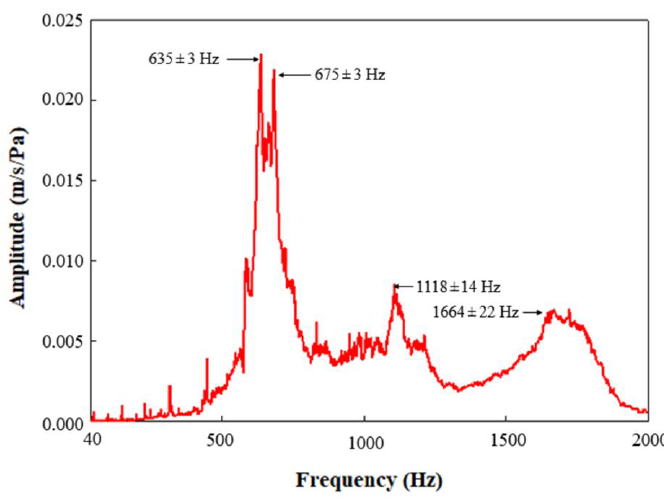
Figure 7. Frequency response function (FRF) of five half-cane specimens with five eigenfrequencies (635 Hz, 675 Hz, 1118 Hz, and 1664 Hz).